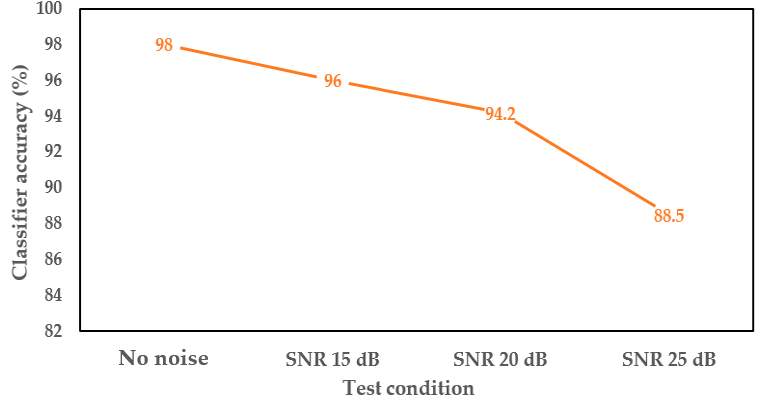
Figure 17. The ideal and noisy outputs of the suggested system.